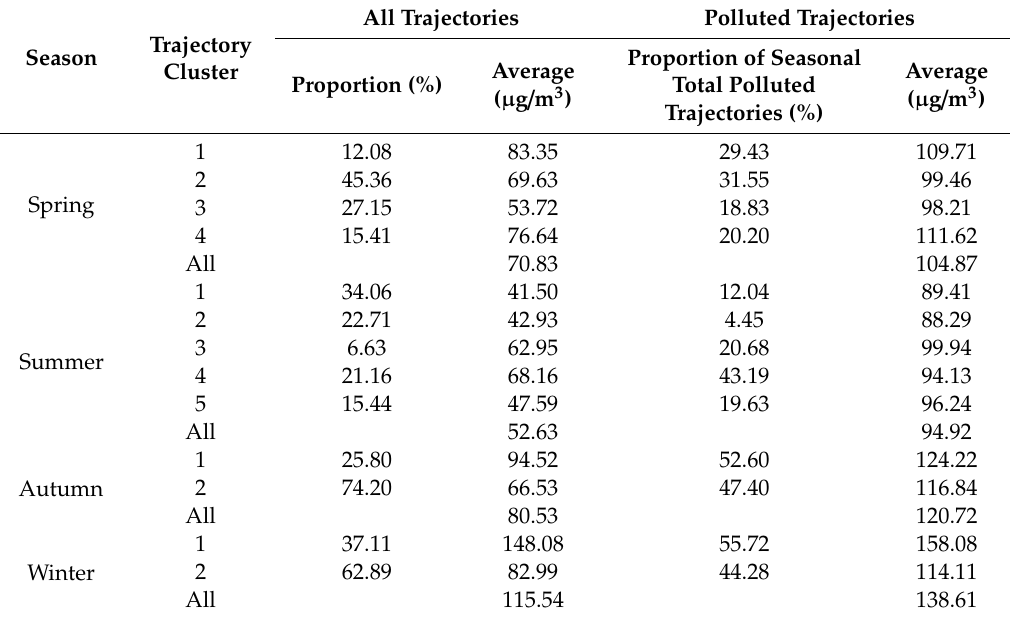
Table 1. Trajectory proportions and PM 2.5 concentrations based on all trajectories and pollution